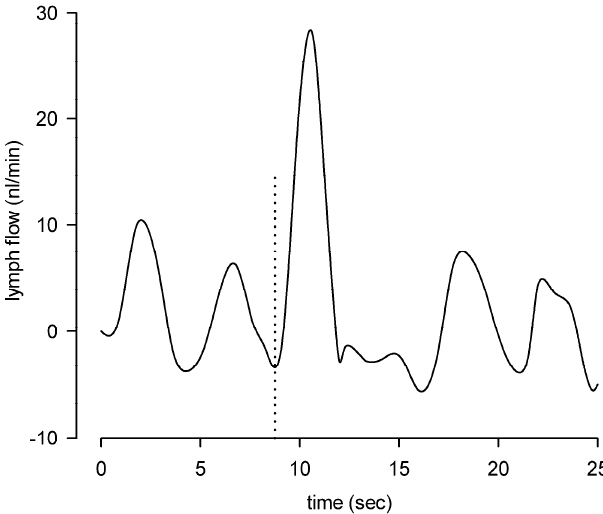
Figure 2. Modulation of lymphatic function: difference in oscillatory lymph flow induced by intrinsic contractions and one extrinsic contraction (experimentally induced at the time point indicated by the vertical dotted line).